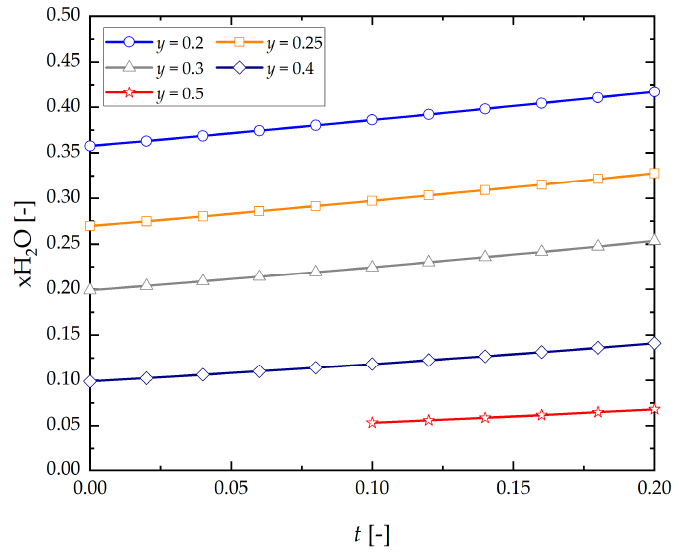
= 𝑓(𝑡, 𝑦) with y=const, of the reforming process = f ( t , y ) with y=const, of the reforming process (cid:3118) (cid:3016) 2 O